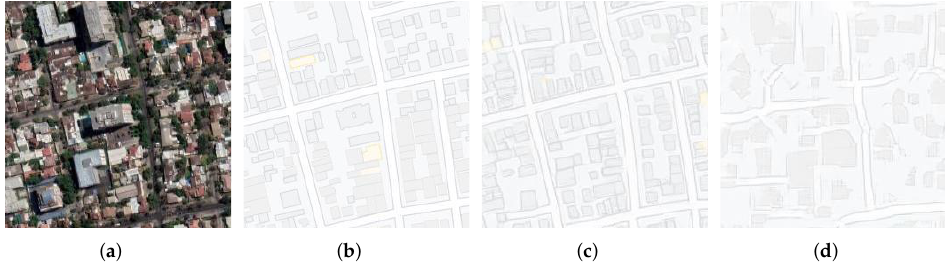
Figure 2. Comparison of output maps generated by Los Angeles-dataset-trained and Beijing-dataset- trained MapGen-GAN testing on Beijing datasets. ( a ) Remote sensing image of Beijing. ( b ) Man-made Google Map of Beijing. ( c ) Beijing map generated by trained MapGen-GAN using Beijing training set. ( d ) Beijing map generated by trained MapGen-GAN using LA training